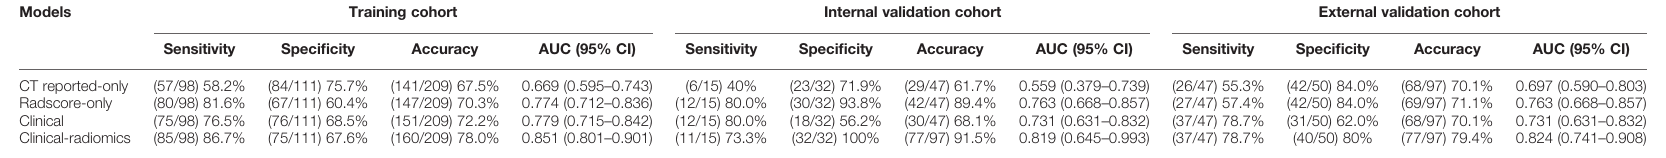
TABLE 4 | Accuracy and predictive value between four models. Models